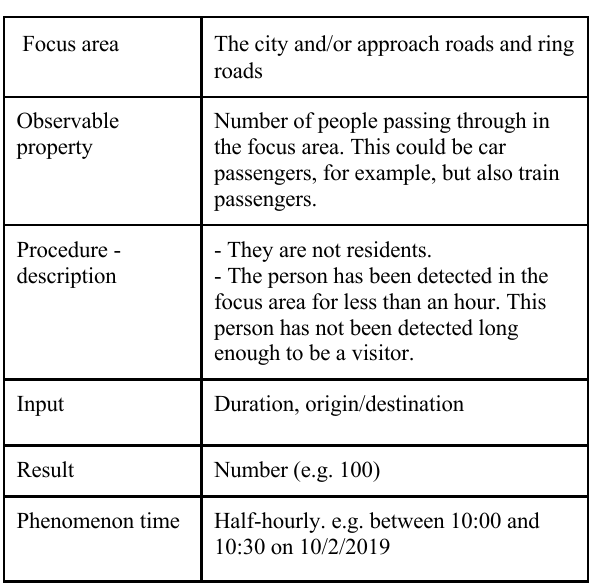
Table 7. Description of the profile “In